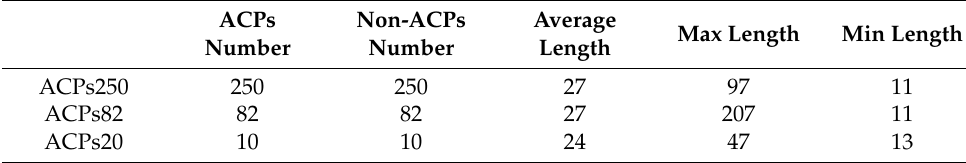
Table 1. Datasets for train, test and independent validation of ACPNet.